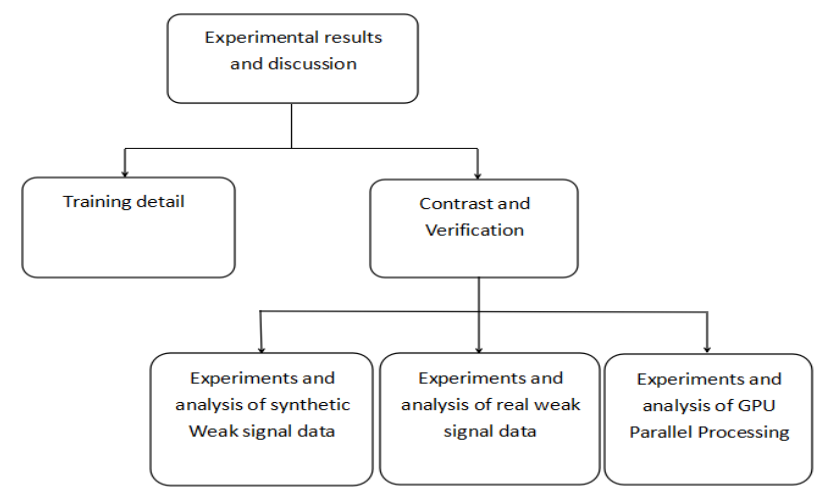
Figure 6. The flow chart of the experimental process.